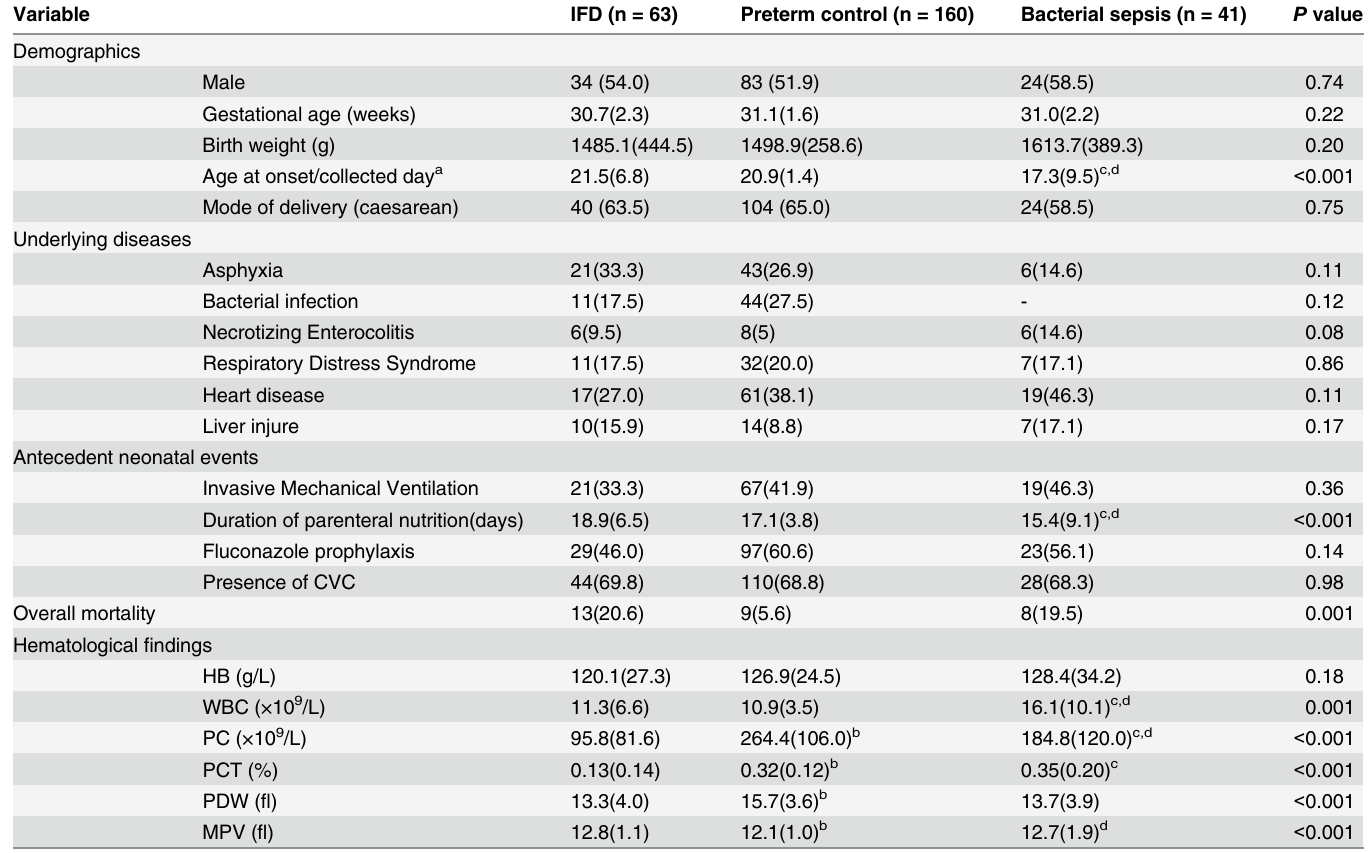
Table 1. Demographics, clinical characteristics and hematological findings in the study population.